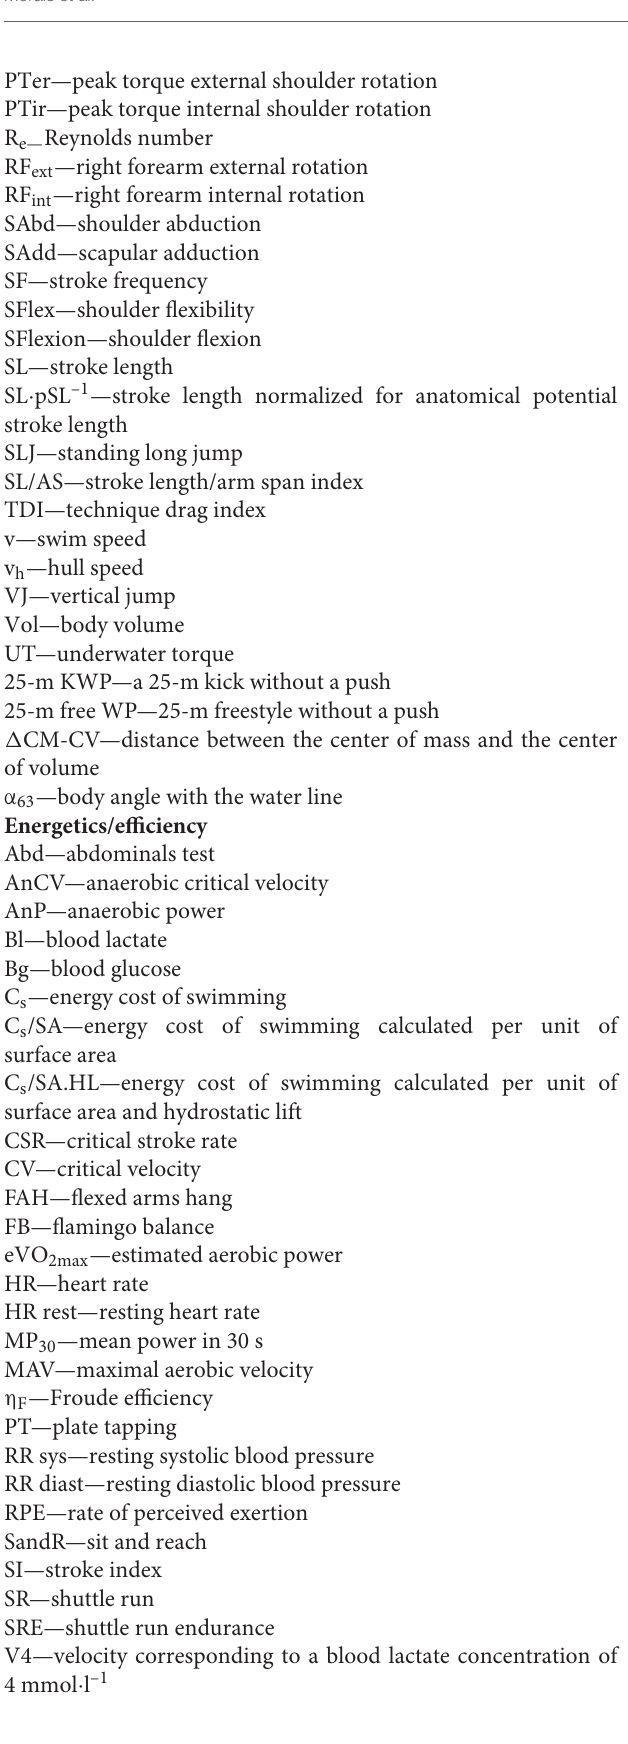
RPE—rate of perceived exertion SandR—sit and reach SI—stroke index SR—shuttle run SRE—shuttle run endurance V4—velocity corresponding to a blood lactate concentration